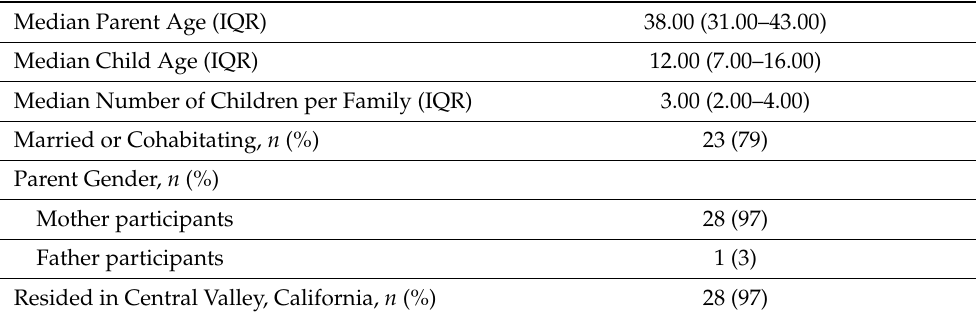
Table 1. Participant